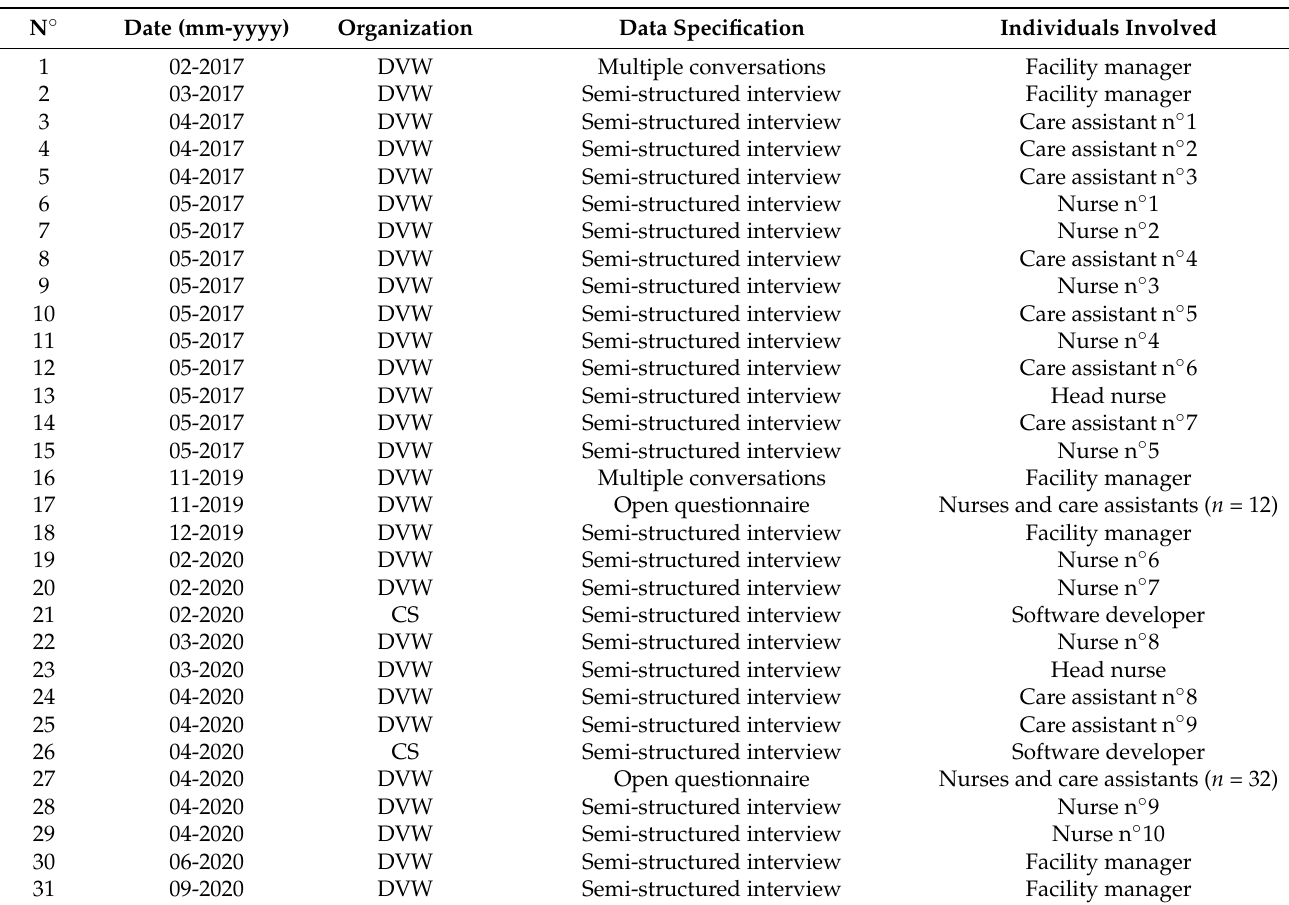
Table A1. Data collection